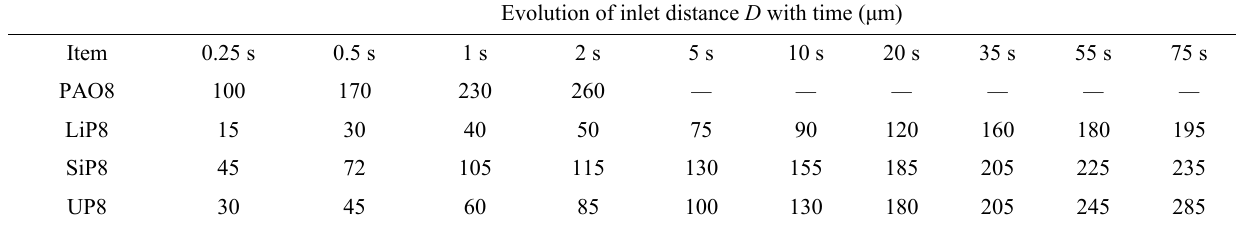
Fig. 4 Reflowing behavior of grease when the test was suddenly halted (test speed: 250 mm/s). Table 2 Oil versus grease in the reflowing behavior around a point